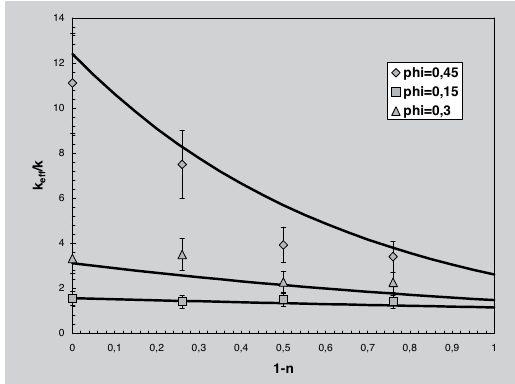
Figure 10 (left): Reduced effective consisten- cy as a function of solid vol- ume fraction, at four power law index values. Figure 11: Reduced effective consis- /k as a function of tency k eff 1 -